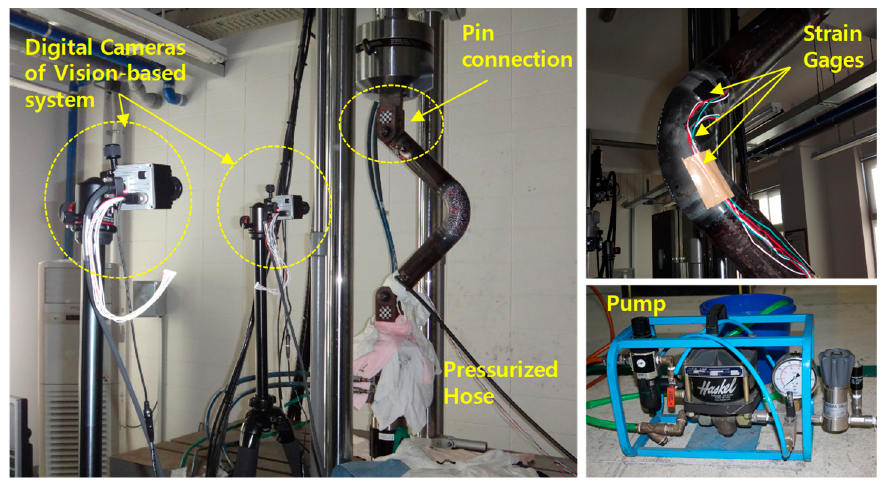
Figure 1. Test specimen and connection jig.